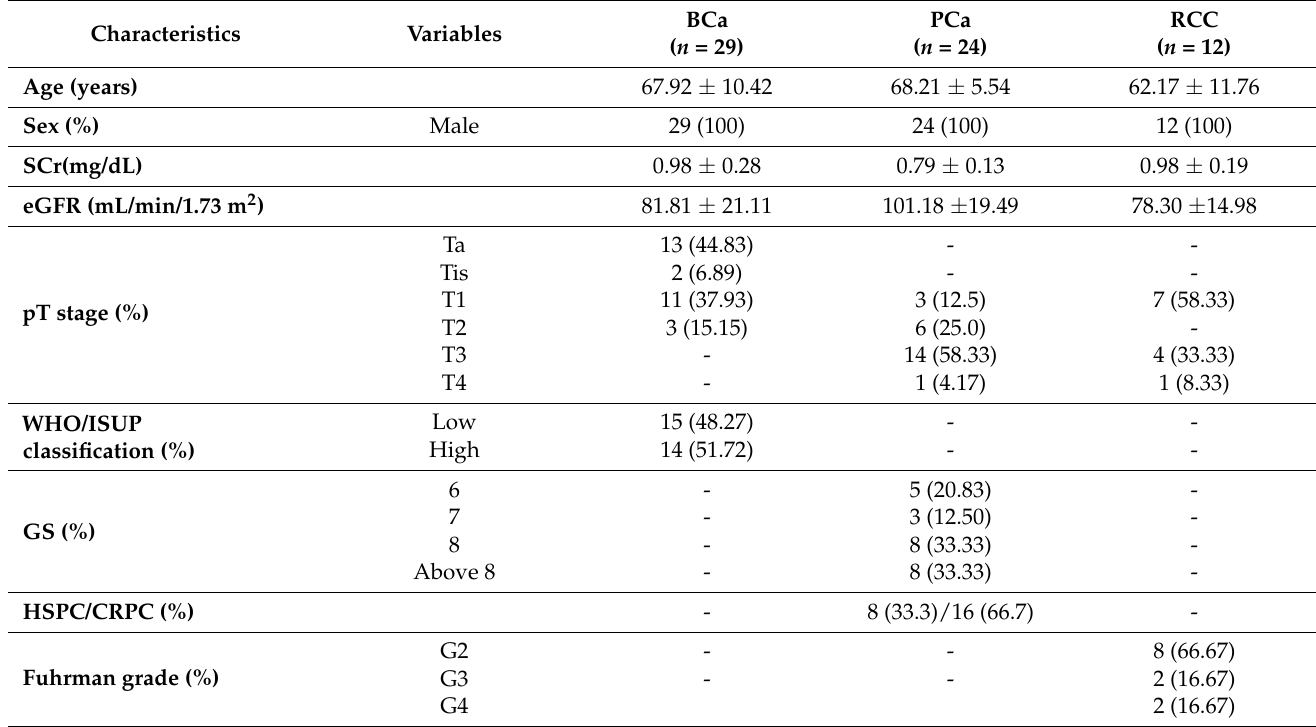
Table 1. Summary of the clinical characteristics of the patients with BCa, PCa and RCC.